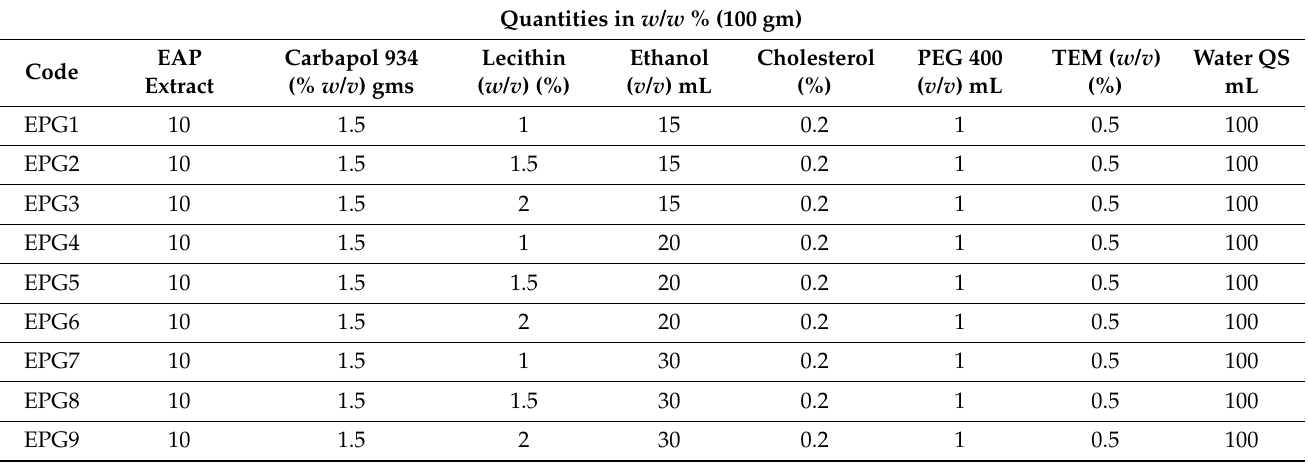
Table 7. Development of ethosomes suspensions of methanolic extract of P. granatum